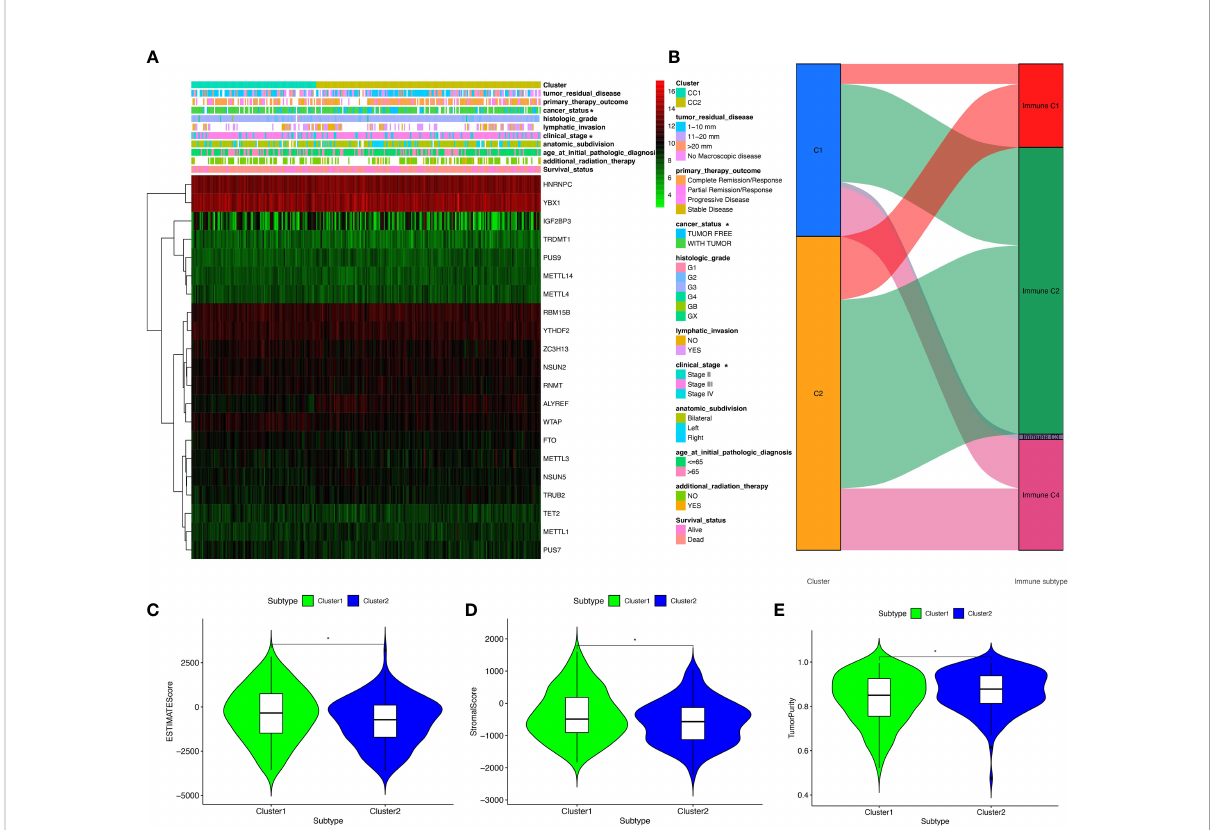
FIGURE 4 The clinical heatmap and immune status between two RNA-modi fi cation subtypes. (A) The clinical heatmap between two RNA-modi fi cation subtypes. (B) The immune types between two RNA-modi fi cation subtypes. (C) StromalScore between two RNA-modi fi cation subtypes. (D) ESTIMATEScore between two RNA-modi fi cation subtypes. (E) TumorPurity between two RNA-modi fi cation subtypes. *p <